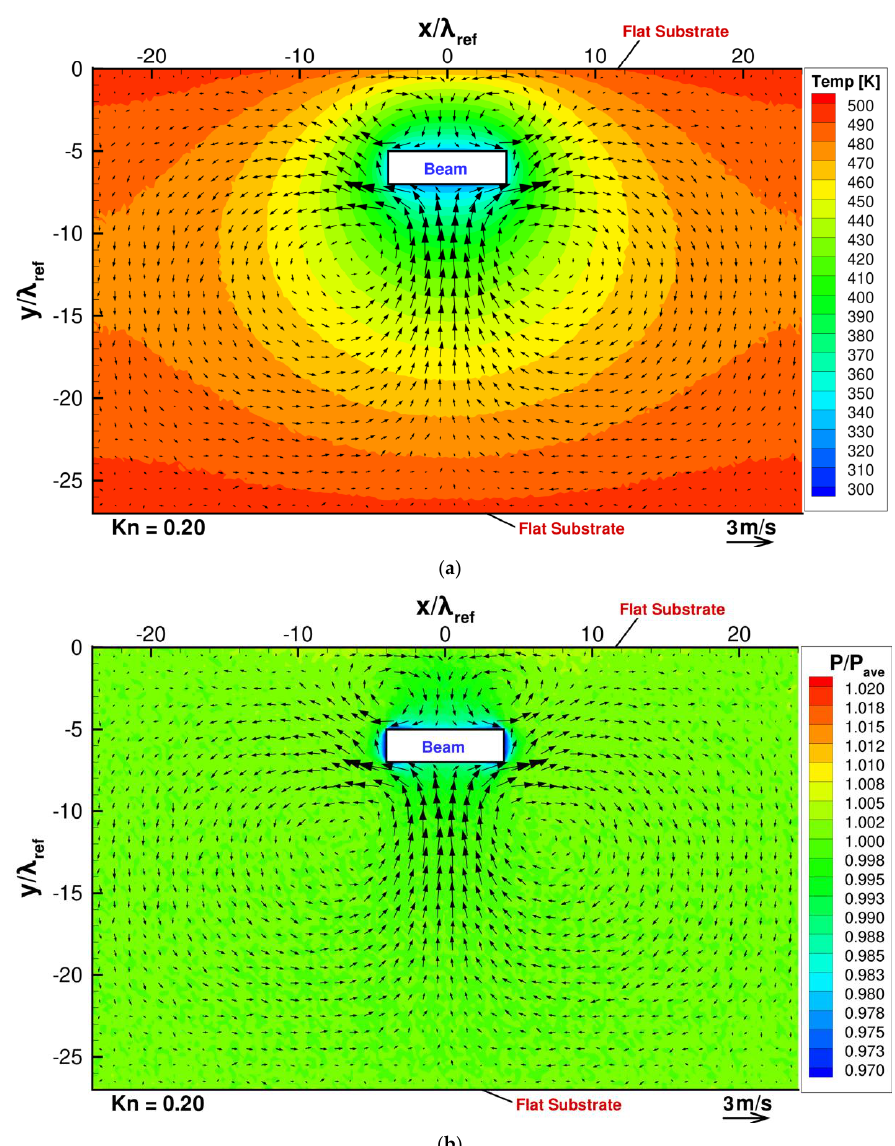
Figure 3. ( a ) Flow and temperature distribution and ( b ) pressure distribution, when the beam is placed close to a heated flat substrate, at Kn =